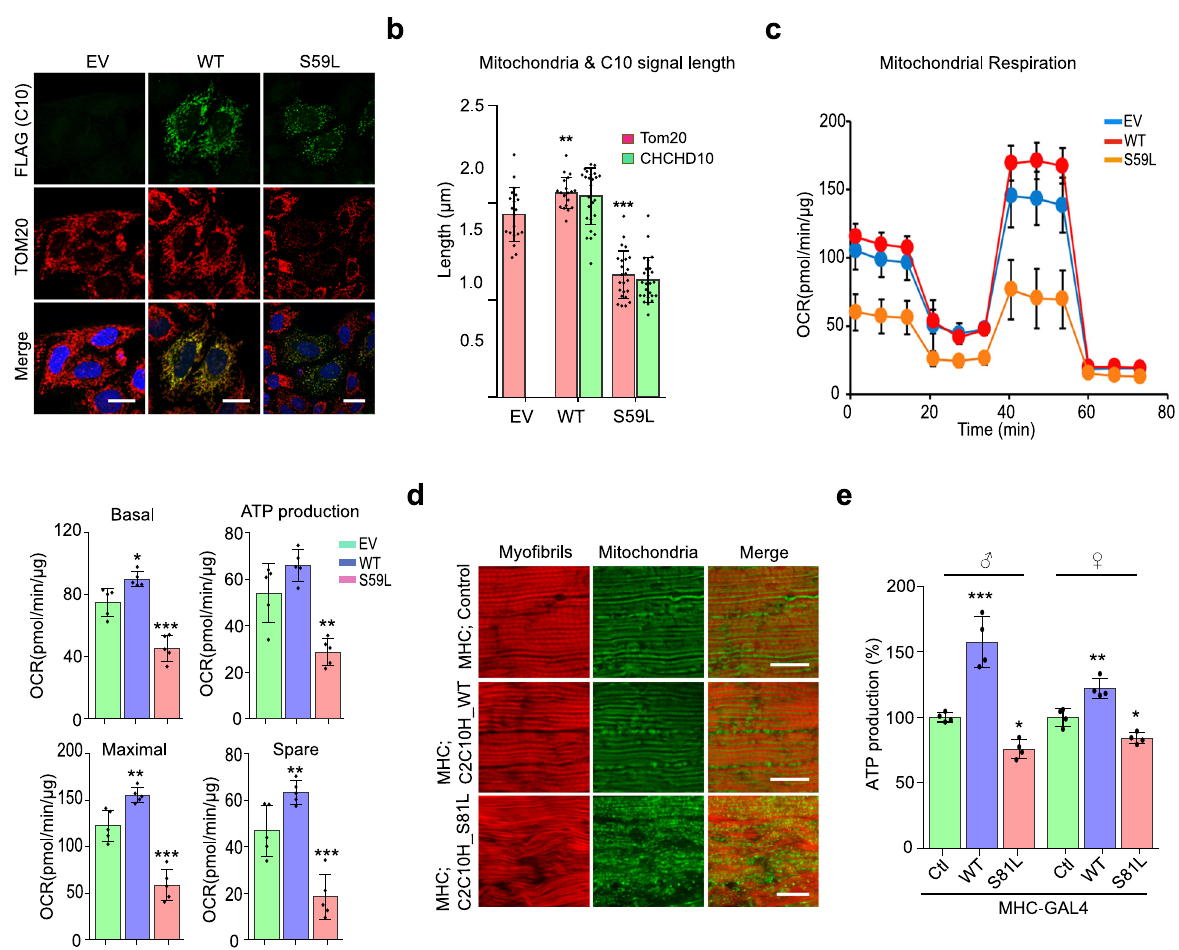
Fig. 2 CHCHD10 S59L mutant induces mitochondrial defects. HeLa cells were transfected with FLAG-tagged CHCHD10 WT , CHCHD10 S59L , and empty vector (EV). a Representative images from three independent experiments of HeLa cells immunostained with antibodies against FLAG (green, transfected CHCHD10 ) and TOM20 (red, mitochondria) 24 h after transfection. Scale bar = 20 μ m. b Quanti fi cation of CHCHD10-FLAG (green) and TOM20 (red) signal length. Data are shown as mean ± SD (one-way ANOVA and post hoc Dunnett test, two-sided, comparison with EV, ** p = 0.0069, *** p = 3.7e − 12; n = 20 – 24 cells from three independent experiments). c Oxygen consumption rate (OCR) for each transfectant was measured. After measuring basal respiration rates, oligomycin, FCCP, and antimycin A/rotenone were serially injected to measure ATP production and maximal respiration, respectively. Spare respiratory capacity was then calculated. Graphs of a single representative experiment are shown (mean ± SD). Actual statistical analyses were performed with 11 independent experiments (one-way ANOVA and post hoc Dunnett test, two-sided, comparison with EV, * p = 0.01867 and *** p = 0.00012 in basal level; ** p = 0.0015 in ATP level; ** p = 0.0071 and *** p = 3.2e − 05 in maximal level; ** p = 0.002453 and *** p = 0.00058 in spare capacity; detailed information on statistical analyses is available in Supplementary Fig. 9a). d Mitochondrial morphology of 45-day-old C2C10H WT - and C2C10H S81L -expressing fl ies. Indirect fl ight muscles were stained with streptavidin – Alexa Fluor 488 (mitochondria, green) and phalloidin – Alexa Fluor 594 (actin fi laments, red). Representative images from two independent experiments with 16 fl ies. Scale bar = 20 μ m. e ATP levels in thoraxes containing muscle tissues of the indicated genotypes (aged 10 days) were measured. Data are shown as mean ± SD (one-way ANOVA and post hoc Dunnett test, two-sided, *** p = 0.00018 and * p = 0.03662 in male; ** p = 0.0015 and * p = 0.011 in female; n = 4 independent (Supplementary Fig. 3d). Consistent with our observations in Drosophila eyes, co-expression of C2C10H WT mitigated the C2C10H S81L -induced mitochondrial fragmentation and ATP production defects in indirect fl ight muscles (Fig. 3b, c). An additional copy of C2C10H S81L exacerbated the defects in both the eyes and muscles (Fig. 3a – c).